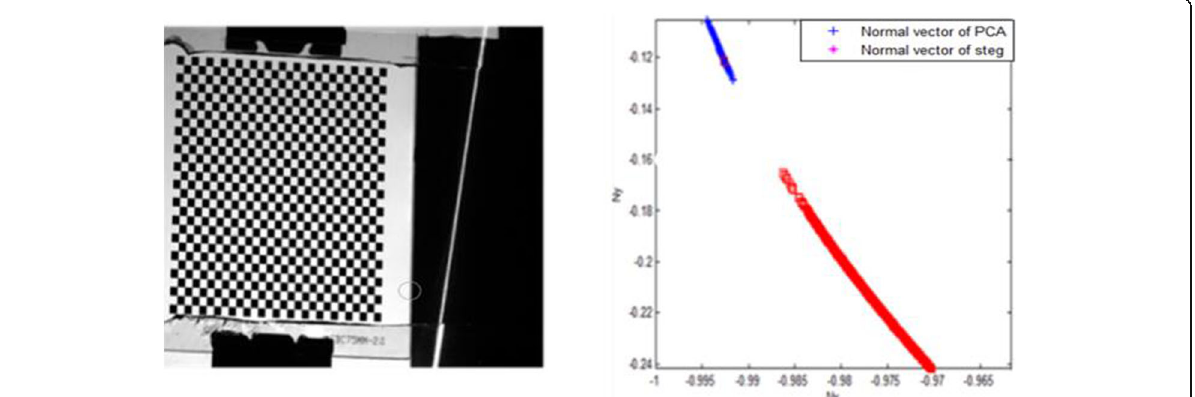
Fig. 9 Image of the plane target and the normal vector of center points (non-vertical state). a The tilt light stripe. b The normal